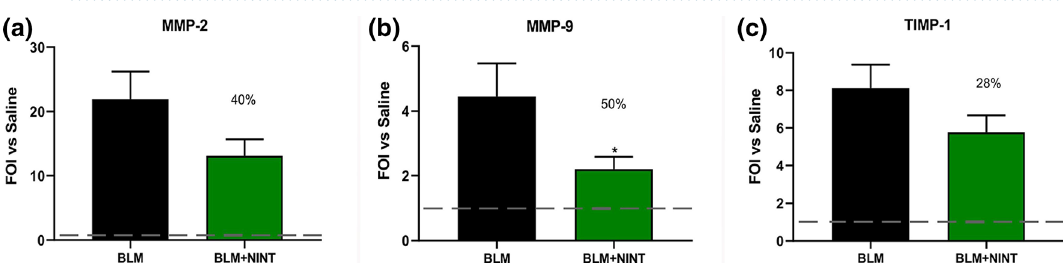
Figure 4. Evaluation of antifibrotic activity of nintedanib on matrix metalloproteinases at day 28 in BALF. MMP-2 ( a ), MMP-9 ( b ) and their inhibitor TIMP-1 ( c ) measured using the specific ELISA kit. The fold of increase vs Saline (FOI vs. Saline) for each group is shown as mean ± S.E.M. for 8 mice per group. The dashed lines indicate the saline values. Asterisks indicate statistical significance of each group vs. BLM (*P < 0.05; one- way ANOVA followed by Dunnett’s test). The percentages on the BLM + NINT bars represent the inhibition effect of the treatment compared to compared to vehicle-treated mice (Fig. 6b). Its antifibrotic effect was also evidenced by the quantification of nor- mally and poorly-aerated lung compartments (Fig. 6c) at the end of pharmacological treatment: poorly-aerated tissue in BLM mice (70%) was significantly higher than in the Saline group (22%), whereas it was reduced in the NINT group (54%).